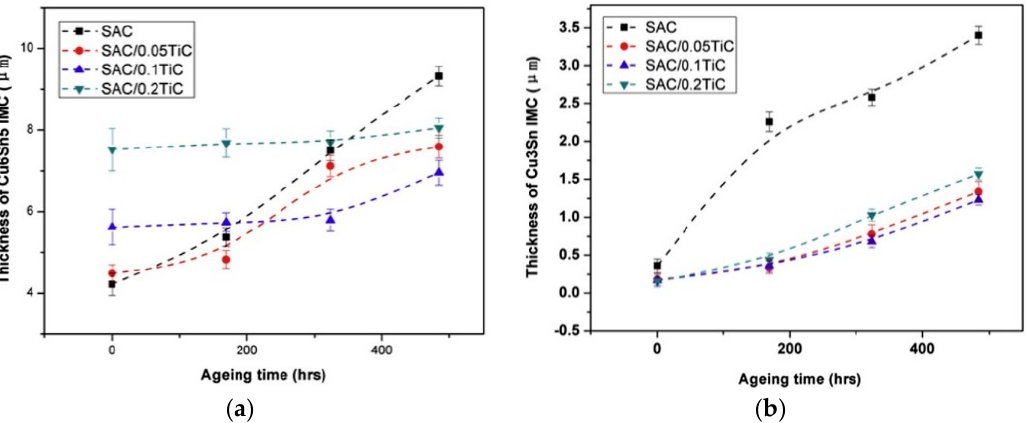
Figure 6. Effect of TiC nanoparticles content on the thickness of IMCs layers during aging ( a ) Cu 6 Sn 5 ; ( b ) Cu 3 Sn [47]. ( b ) Cu 3 Sn